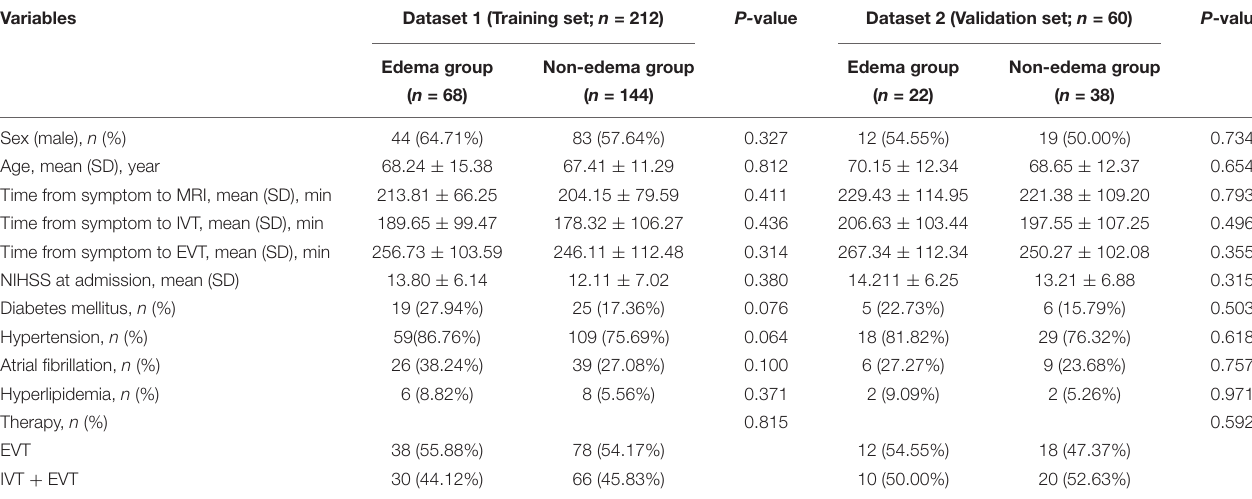
TABLE 1 | Baseline characteristics of the study population. Variables